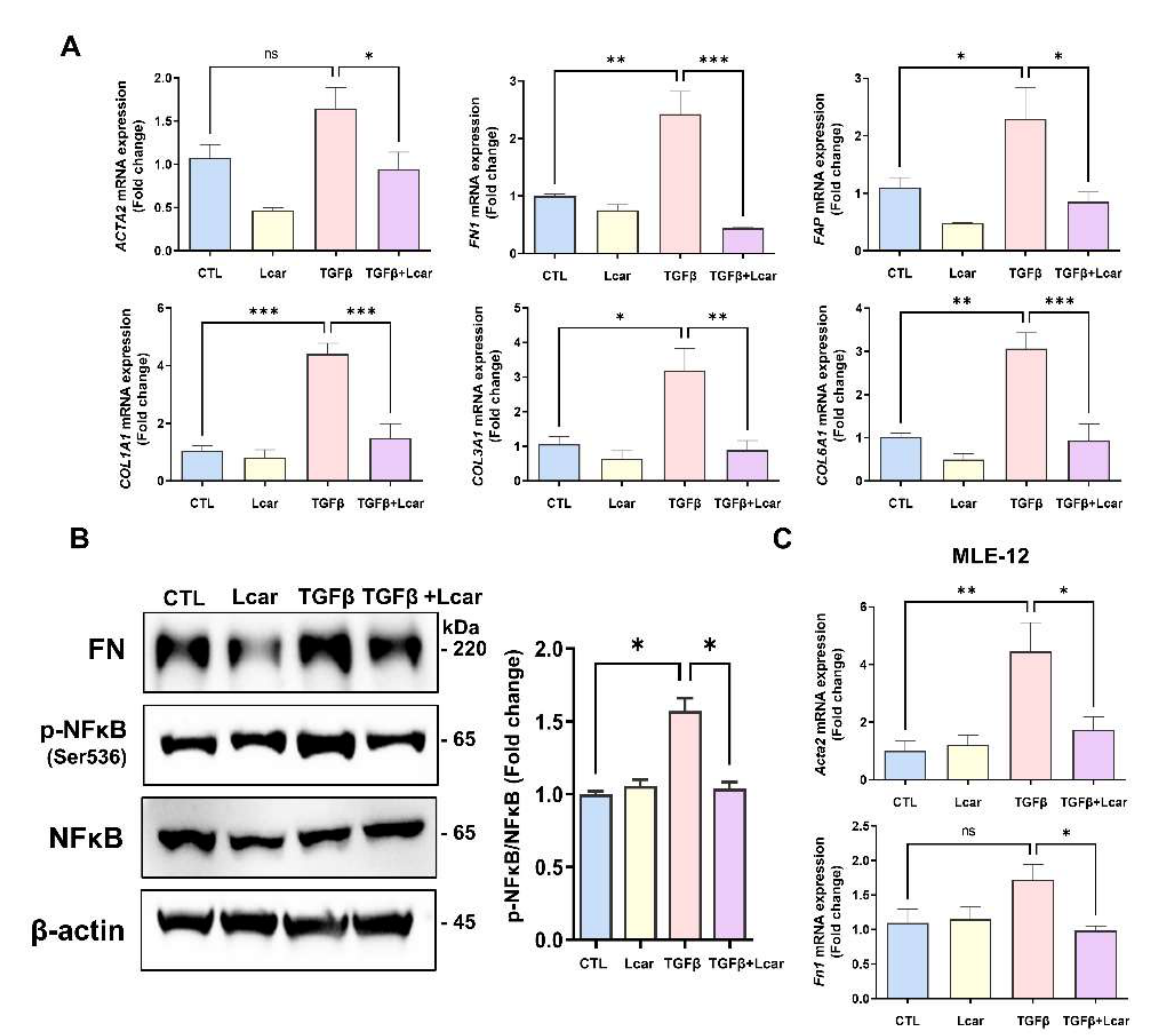
Figure 5. L-carnosine downregulated fibrogenesis in fibroblasts and lung epithelial cells. Human lung fibroblast (MRC-5) and mouse lung epithelial cell (MLE-12) were stimulated with human recombinant TGFβ and mouse recombinant TGFβ for 48 h and 72 h, respectively. L-carnosine was treated MRC-5 (10 mM) and MLE-12 (30 mM) at the same time. ( A ) mRNA expression of fibrosis-related